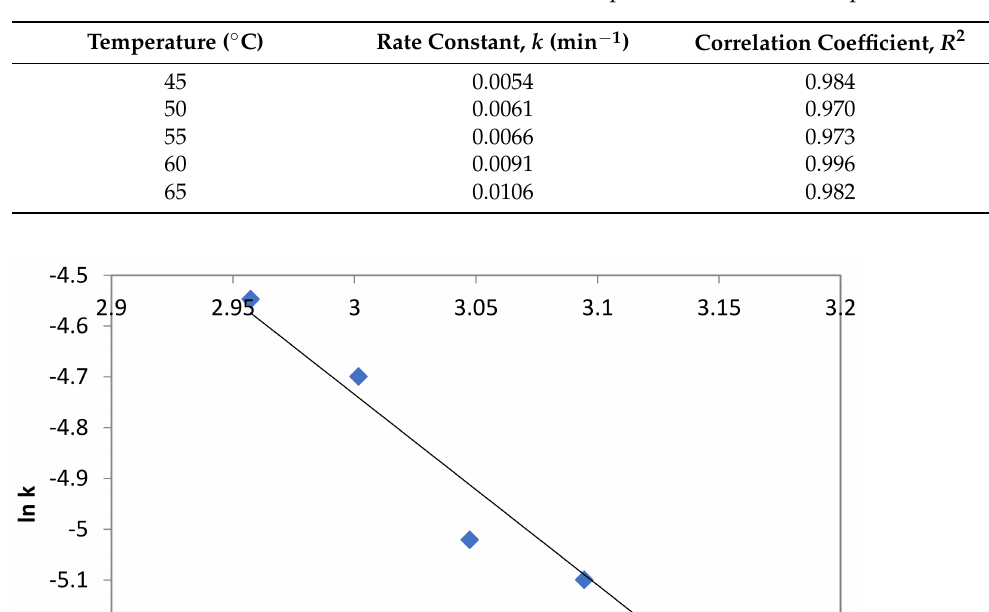
Figure 7. Plot of –ln (1 − X) versus reaction time at different temperatures. Table 2. Reaction rate constants for the transesterification of palm oil at different temperatures.